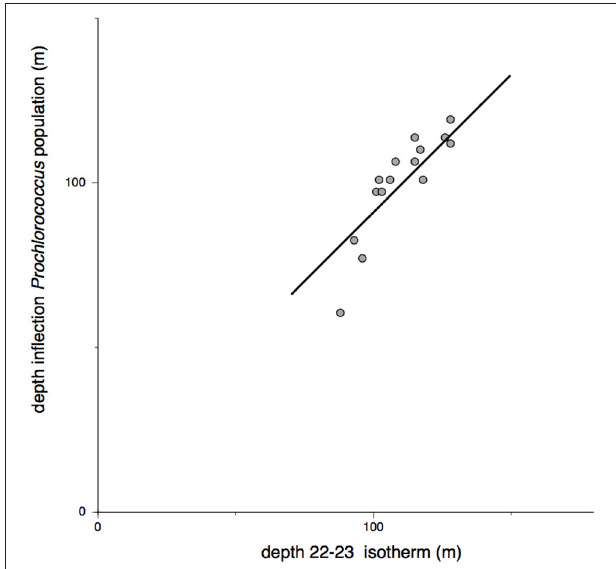
FIGURE 5 | Relationship between Prochlorococcus abundance and the depth where water temperatures drop from 23 to 22 ◦ C. The line is drawn at an angle of 45 ◦ through the mean of the x and y